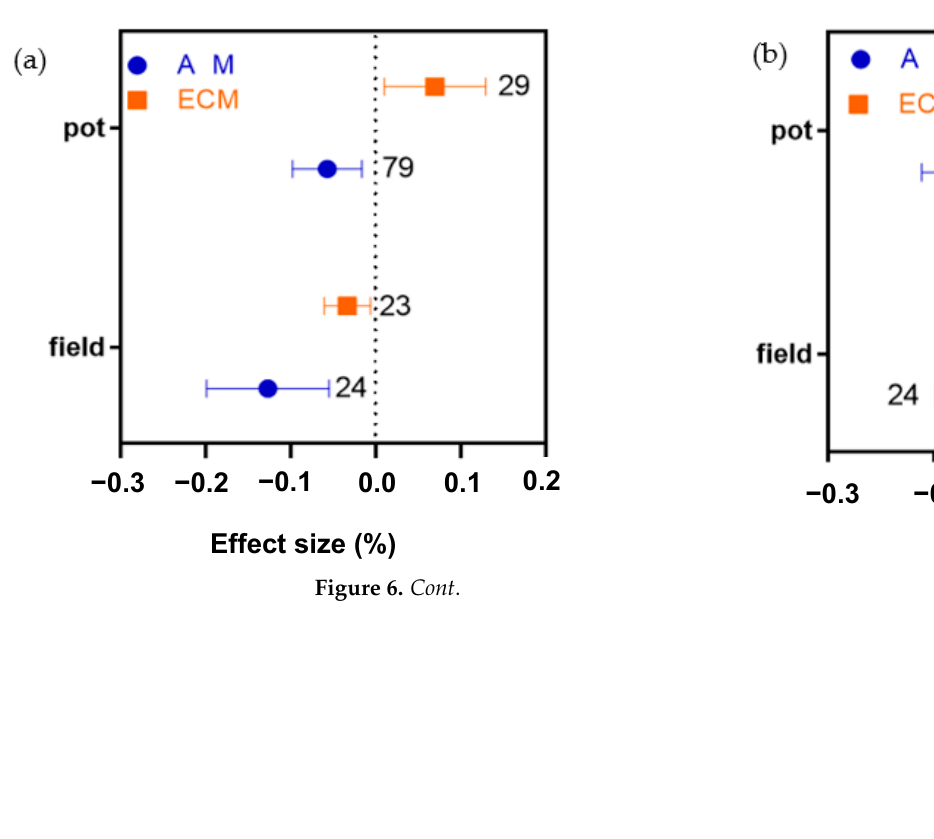
Figure 6. The average effect of drought on ectomycorrhizal plant N, ( a ) P, ( b ) and N:P ratio, ( c ) and arbuscular mycorrhizal plant N, ( a ) P, ( b ) and N:P ratio, ( c ) under field or pot experiment. The error bar represents a 95% bootstrap confidence interval (CI). If the 95% CI of effect size did not overlap with zero, drought stress was considered to be the effect. The number of observations for each cat- egory is shown next to the error bar. 2.8. Effects of Other Factors on N, P, and N:P Ratio of AM and ECM Plants In addition to drought patterns, drought time also analyzed whether species distri- bution and planting conditions affected plant N, P, and N:P ratio. The results showed that planting conditions also had significant effects on plant nitrogen ( p = 0.01028 < 0.05) . Plant N, P, and N:P ratio were not affected by species distribution and their cross-pollination Table 1. The effect of mycorrhiza type, planting condition, species distribution and their interaction on the N, P, and N:P ratio in AM and ECM plants based on linear mixed effect models planting conditions, species distribution and their interaction are fixed effects. Mycorrhizal type is random effects. Planting Conditions (PC)